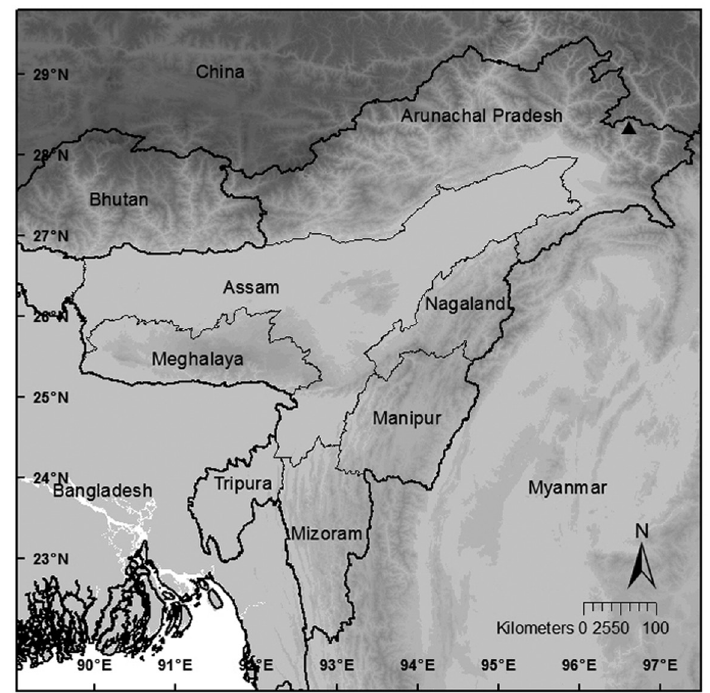
Fig. 19. Map showing the location of B. cathcartii Hook.f. specimens.